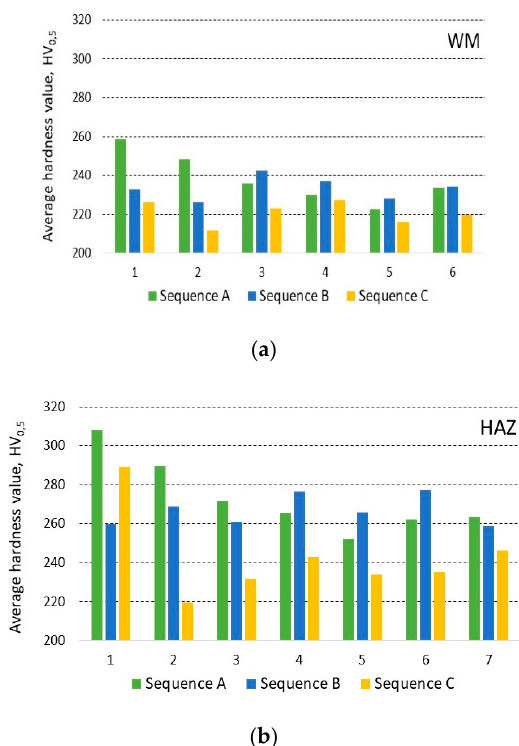
Figure 20. Average hardness value HV 0.5 of ( a ) weld metal (WM) and ( b ) of heat-affected zone (HAZ), measured on cross-sections of plates from left to right.